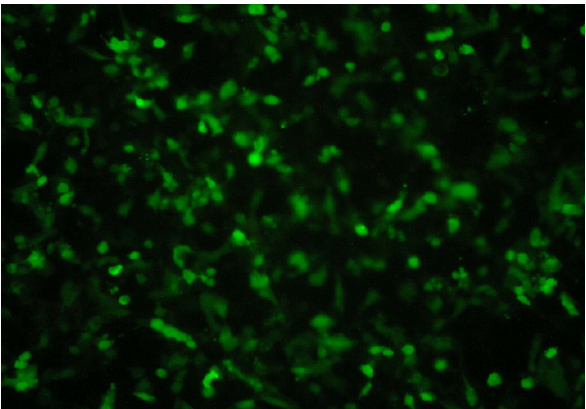
Figure 4. Fluorescence microscopy result of MCF7/ADM 96 h after lentiviral infection (MOI = 6 × 120). The condition of lentiviral infected cells is good and the percent of cells expressing green fluorescent protein is more than 90%.